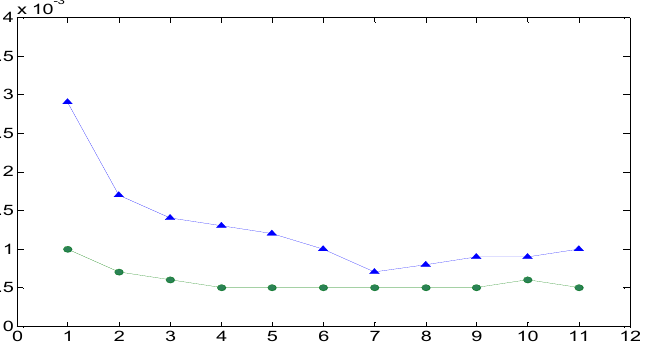
Figure 1. Average intraday spread over a trading day. Note: CS spread (green) and BHL spread (blue). Table 9. Summary statistics of intraday spread measures.